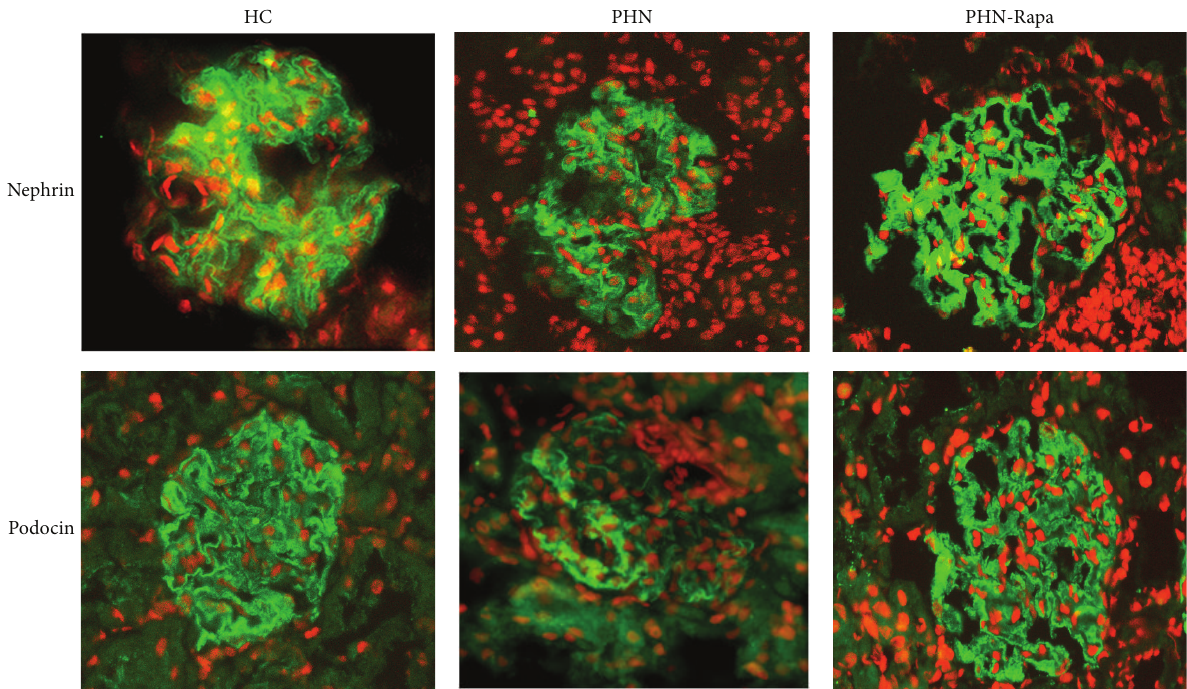
Figure 7: Immunofluorescence staining for nephrin and podocin. HC: healthy controls; PHN: Passive Heymann Nephritis; PHN-Rapa: Passive Heymann Nephritis after rapamycin administration. Nuclei have been stained with propidium iodide (red). Intense (3+) linear staining in the HC and PHN-Rapa groups in contrast to the PHN group which presented attenuated and irregular pattern of staining for both nephrin and podocin (middle